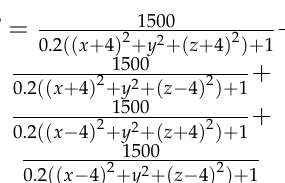
Table 1. Parameters of ART algorithm.